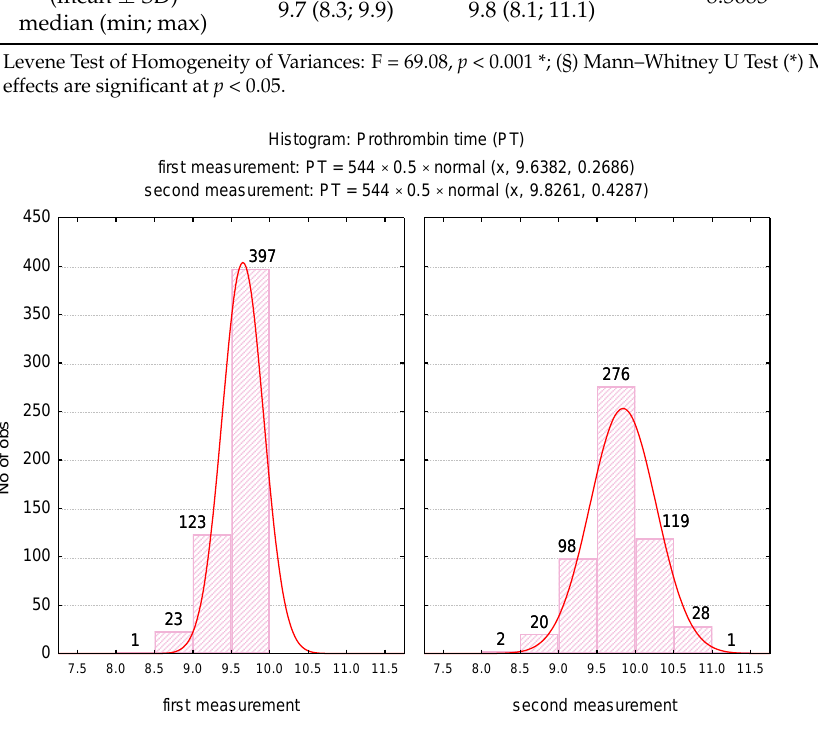
Table 1. Prothrombin time (PT) values depending on the time of determination. The Moment of Determination Statistic Test § p -ValueFirst Second Determination Determination